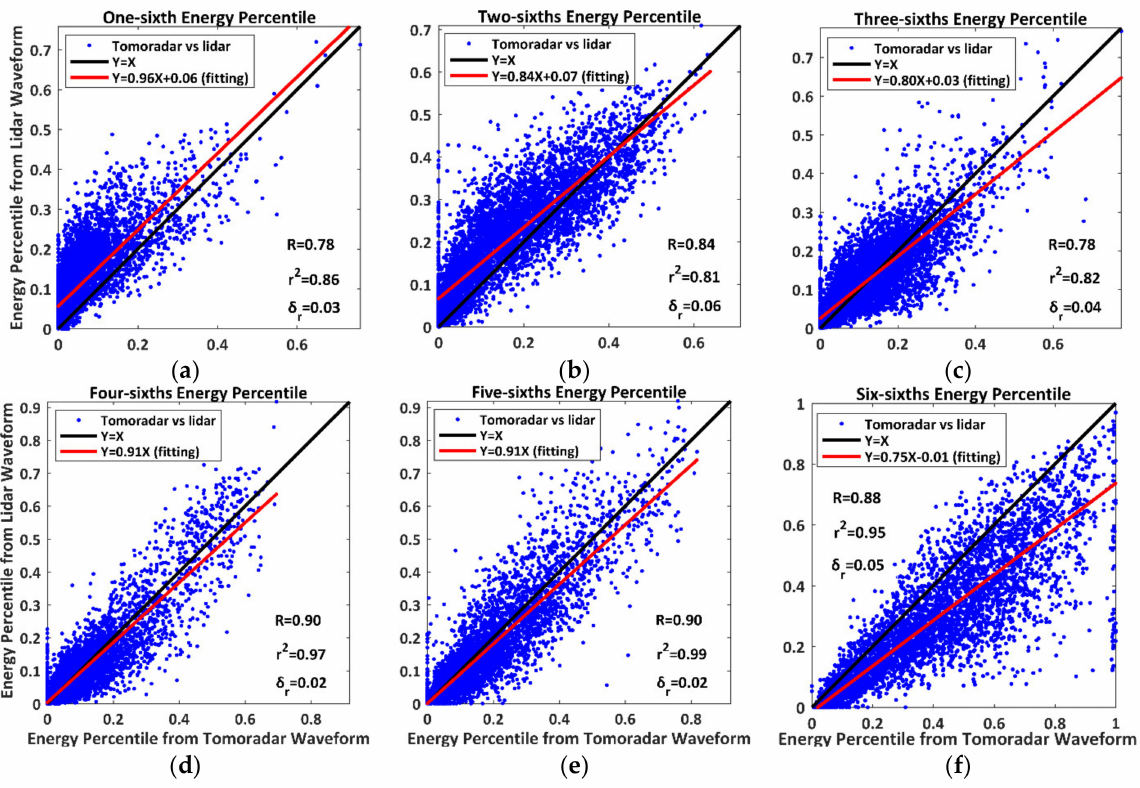
Figure 8. The scatterplots and linear regression results of energy percentiles derived from Tomoradar waveforms (EP t ) and satellite lidar waveforms (EP l ). The symbol R represents the correlation coefficient between EP t and EP l . ( a ) 1/6; ( b ) 2/6; ( c ) 3/6; ( d ) 4/6; ( e ) 5/6; ( f )